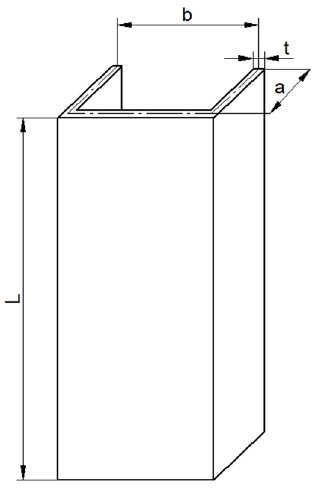
Figure 1. The object of the study.